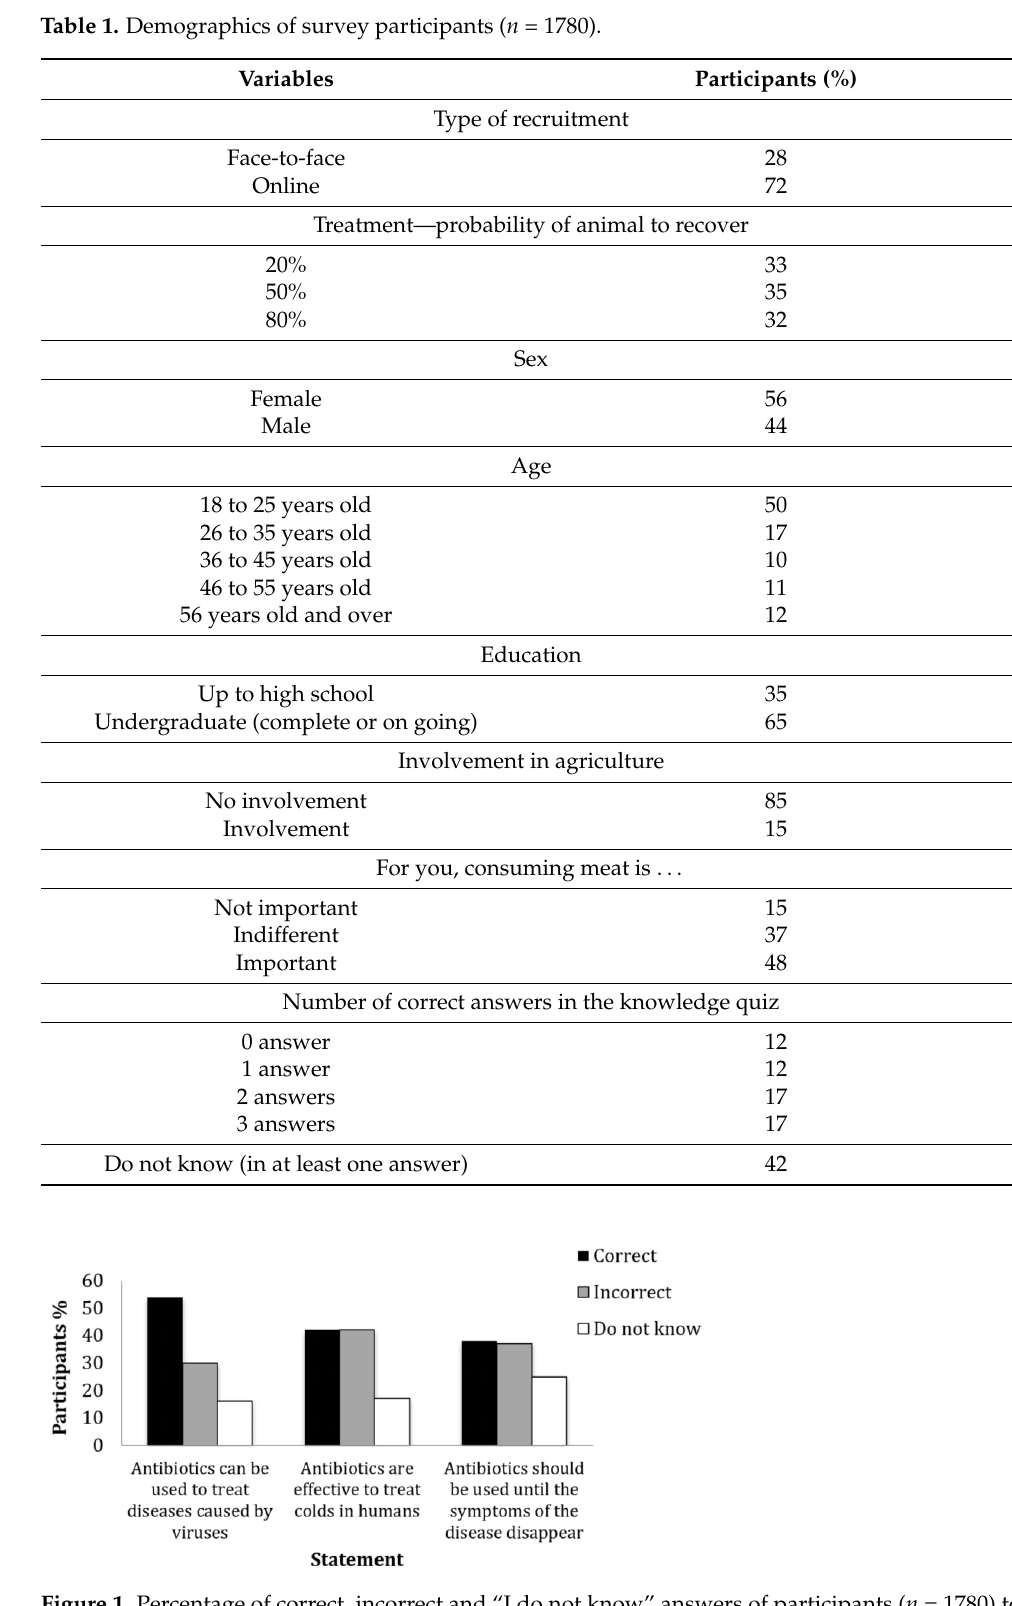
Figure 1. Percentage of correct, incorrect and “I do not know” answers of participants ( n = 1780) to the three questions of the knowledge quiz on the use of